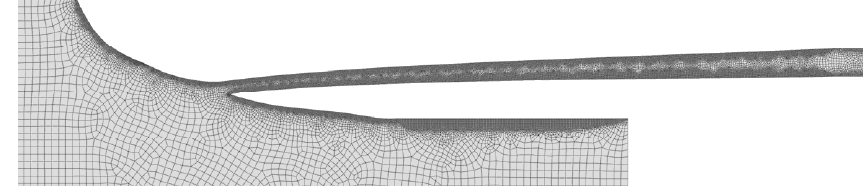
Figure 10. Example of Model 1 meshing.